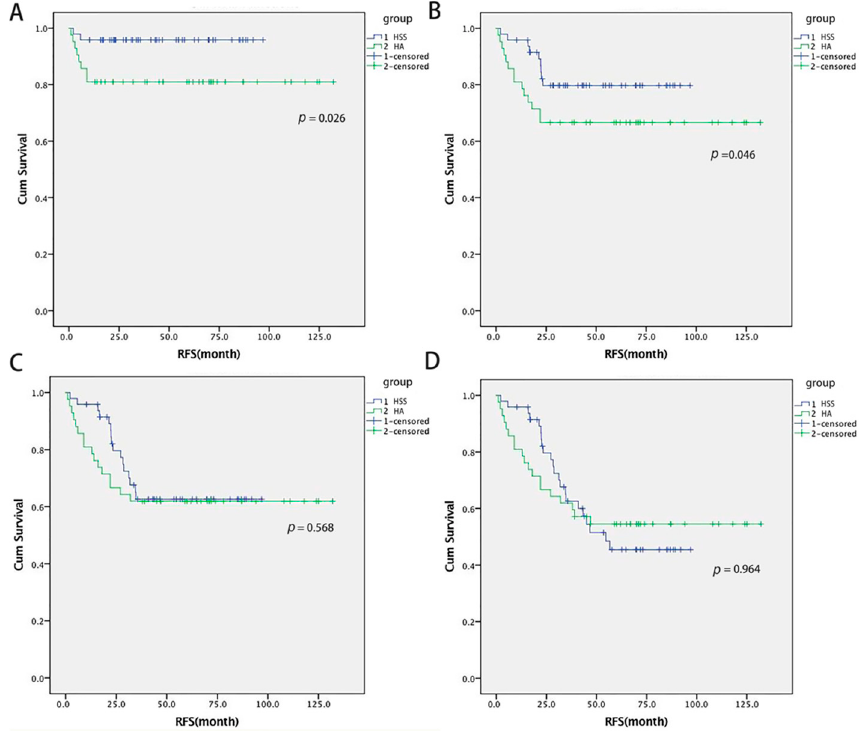
Figure 2. The RFS curves at different time points compared between the HSS group and HA group ( A : 1-year RFS; B : 2-year RFS; C : 3-year RFS; D : 5-year